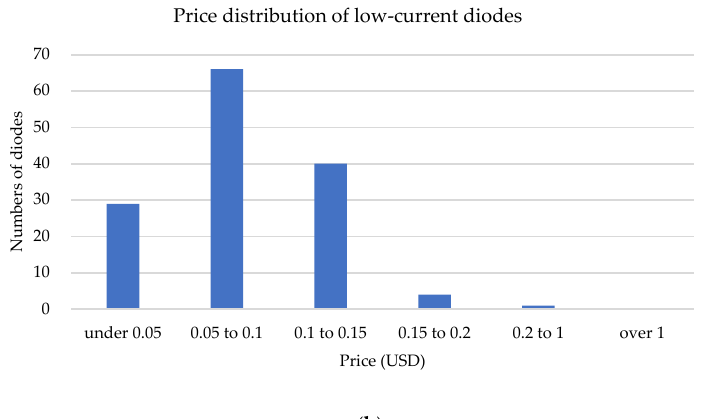
Figure 9. Price distribution of diodes: ( a ) with the rated voltage between 500 V and 1000 V; ( b ) with rated current less than 1 A.